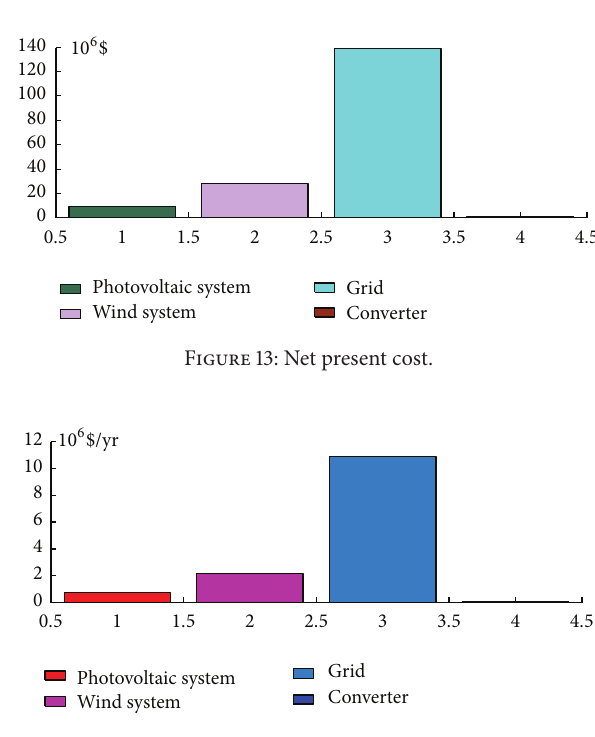
Figure 14: Annual net cost. Table 1: Cost comparison between a standard system (grid) and a hybrid system (PV-wind-grid).